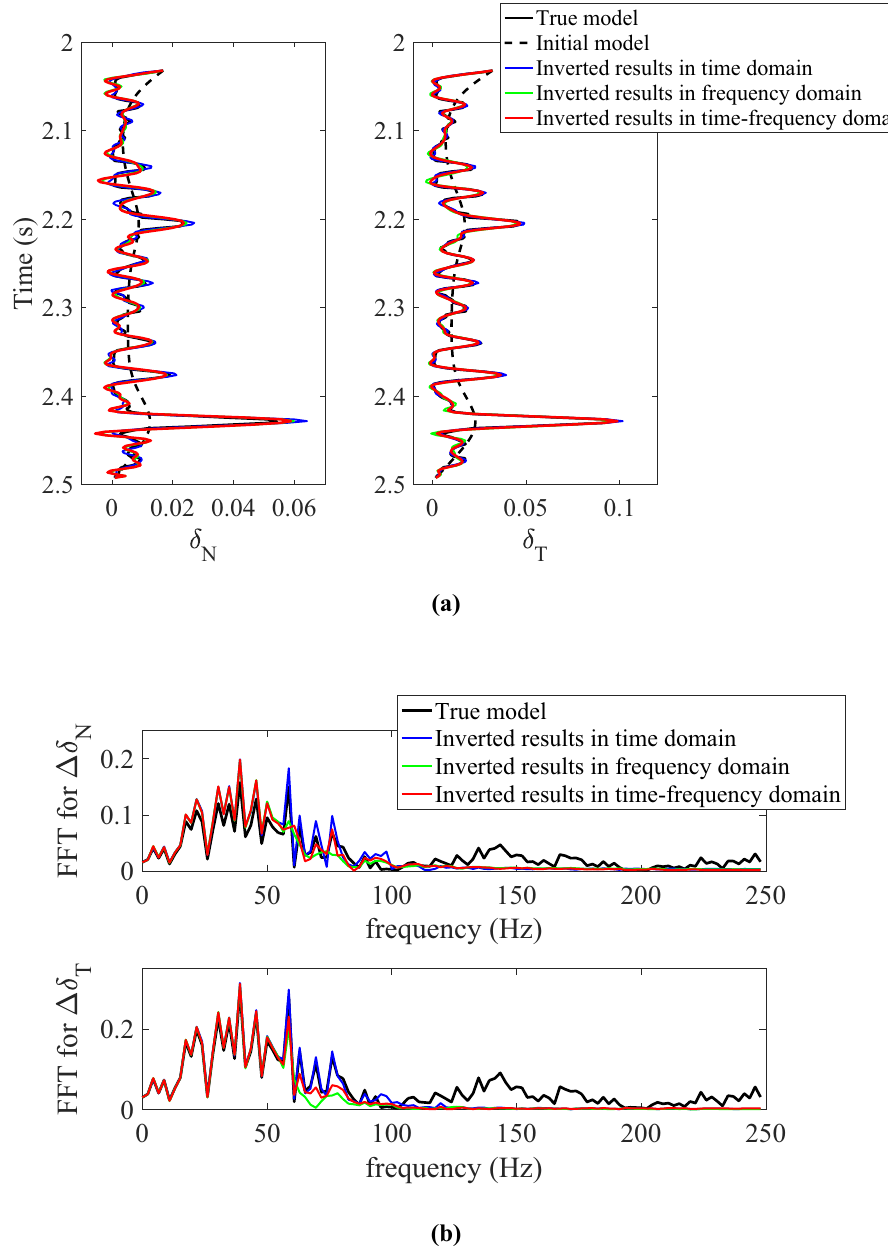
Figure 1. Comparison between original and inverted model parameters and spectra in time domain, frequency domain, and joint time–frequency domain with synthetic azimuth-dependent seismic data containing no noises, where (a) is the inverted normal and shear fracture weaknesses in different domains, and (b) is the spectra comparison in different